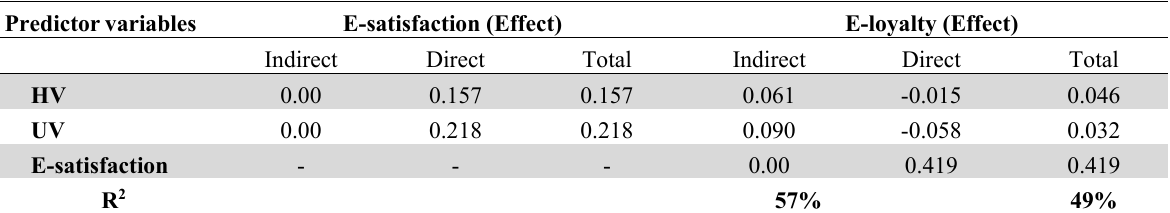
Direct, indirect and total effects Predictor